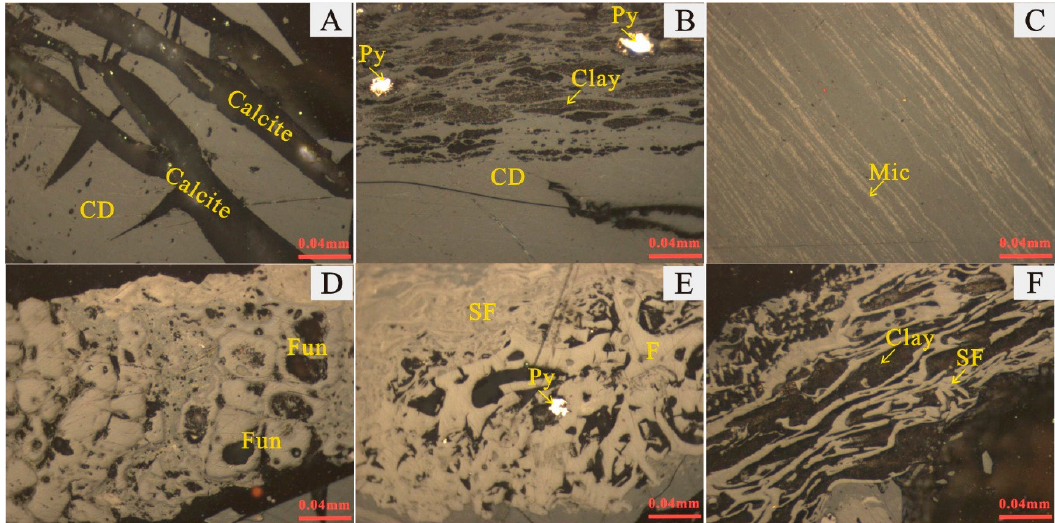
Figure 3. Vitrinite and inertinite in the coals from Dongpo Mine. Reflected light, oil immersion. ( A ) Calcite filled fractures in the collodetrinite in sample DP5 − 2 -5, ( B ) Collodetrinite with cell-filling clay minerals and pyrite in sample DP5 − 2 -6, ( C ) Micrinite in sample DP5 − 2 -2, ( D) Funginite in sample DP5 − 2 -2, ( E ) Fusinite, semifusinite and pyrite in sample DP5 − 2 -5, ( F ) Semifusinite with cell-filling clay minerals in DP5 − 2 -8. CD, Collodetrinite; Py, Pyrite; Mic, Micrinite; Fun, Funginite; SF, Semifusinite; F, Fusinite; Clay, Clay